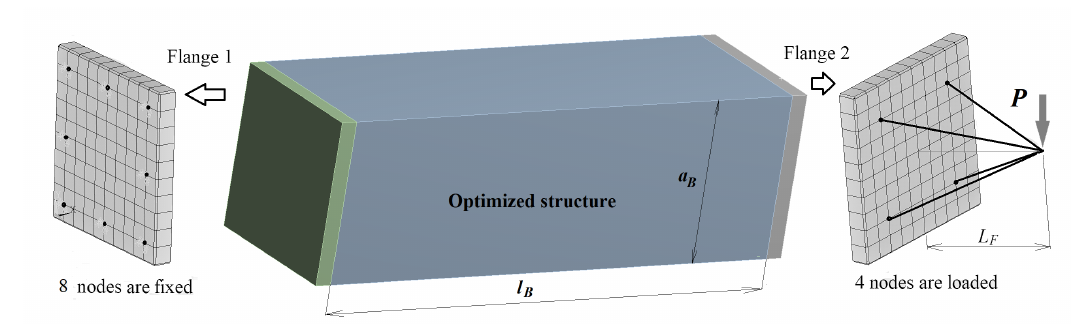
Figure 3. The basic arm